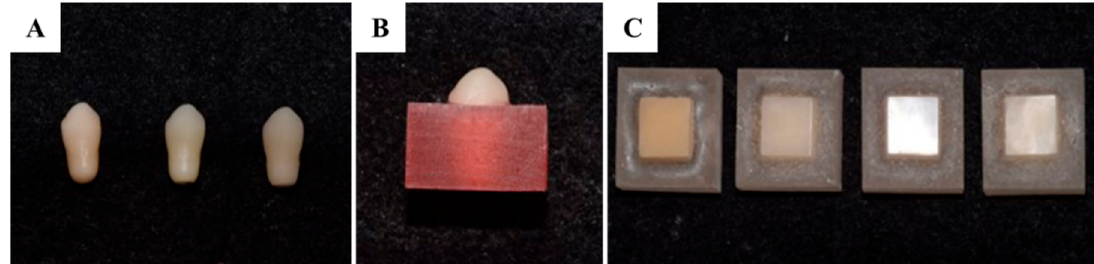
Table 2. Post milling procedure of the lithium disilicate and zirconia.